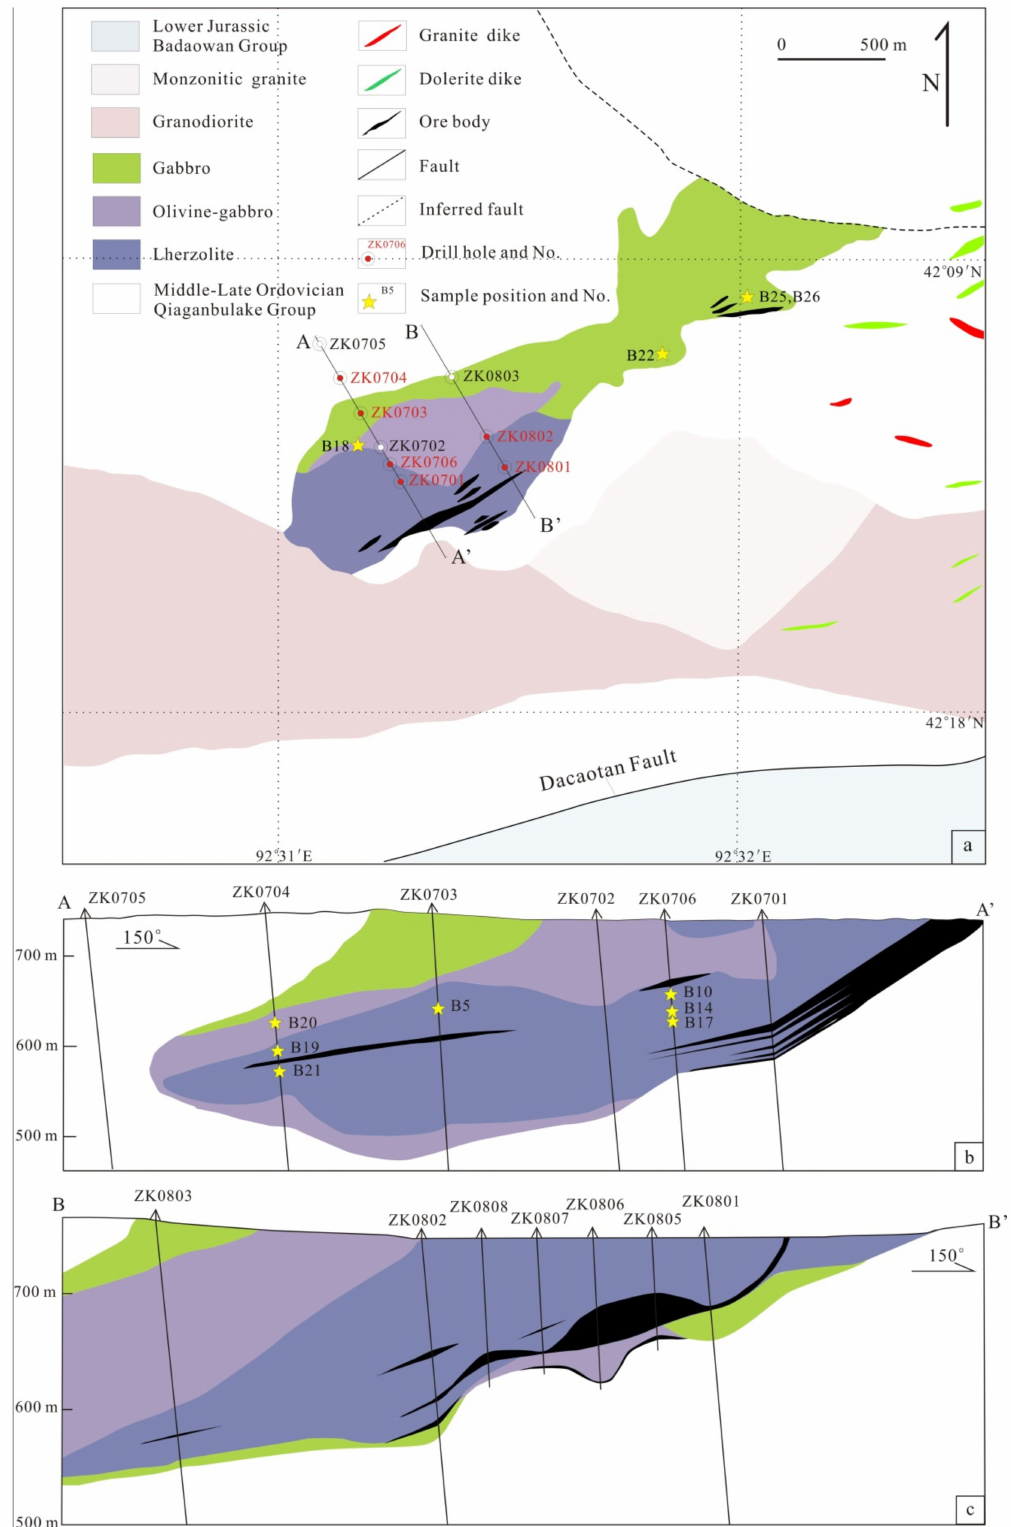
Figure 2. ( a ) The simplified geological map of the Baixintan intrusion; ( b ) cross section A-A’; ( c ) cross section B-B’ (modified from [65]). The near vertical lines in ( b ) and ( c ) are drill